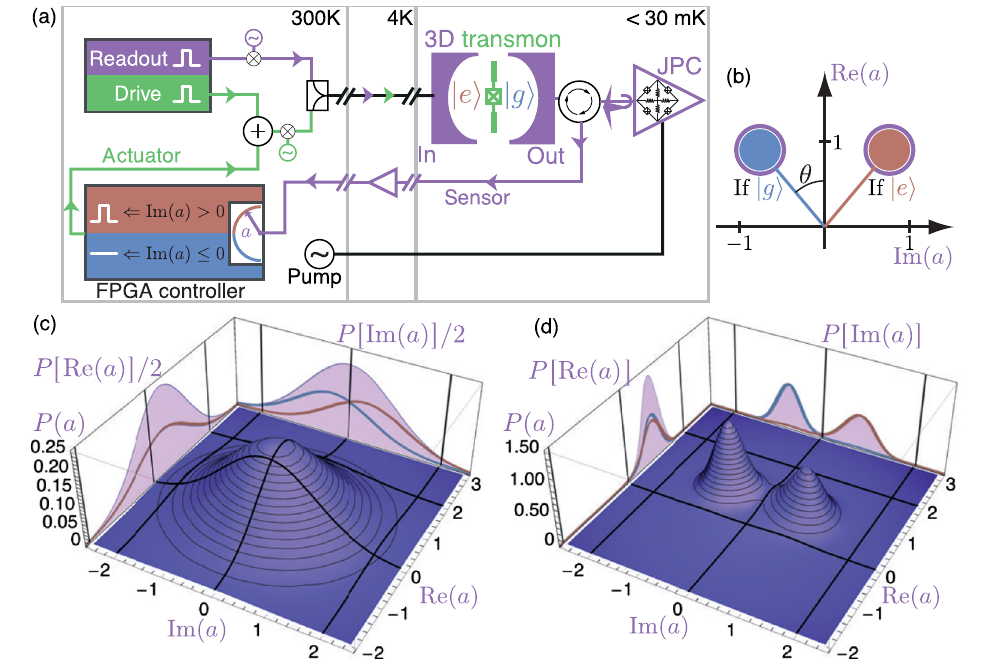
FIG. 1. (a) Schematics of the experiment. The state of a 3D transmon qubit is entangled with the phase of a coherent field transmitted ¼ ! (cid:1) (cid:5) . It is amplified by a Josephson parametric converter (JPC), and its complex amplitude a through the cavity at frequency ! r c is measured and averaged by digital demodulation using an FPGA board (sensing and control). The drive at qubit transition frequency ! is modulated by the sum of a predetermined waveform and of a conditional one generated by the FPGA board (actuation). If the eg transmission measurement points toward state j e i , the actuator generates a (cid:2) pulse to get the qubit back in j g i . (b) Expected complex represented as the rod of a lollypop in the Fresnel space amplitude of the field in the cavity averaged over the measurement time T meas ¼ 11 averaged modes is represented by the for both qubit states. The typical deviation due to vacuum fluctuations of the field in the N m lollypop radius. The limited measurement efficiency ( (cid:8) ¼ 67% ) only slightly increases the observed deviations by (cid:8) (cid:1) 1 = 2 (cid:1) 1 ¼ 22% (purple rings). (c),(d) Probability density with the JPC (c) off and (d) on, extracted from 10 6 measurement outcomes when the qubit is prepared in state j g i or j e i with equal probability. Each outcome is the complex averaged amplitude of the field inside the transmon . The halved probability density that corresponds to the preparation of j g i only (respectively, j e i ) is plotted in blue cavity at ! r (orange), together with the projections along the real and imaginary axes. Turning on the pump of the amplifier as in (d) results in a great enhancement of the measurement fidelity, compared to the case without